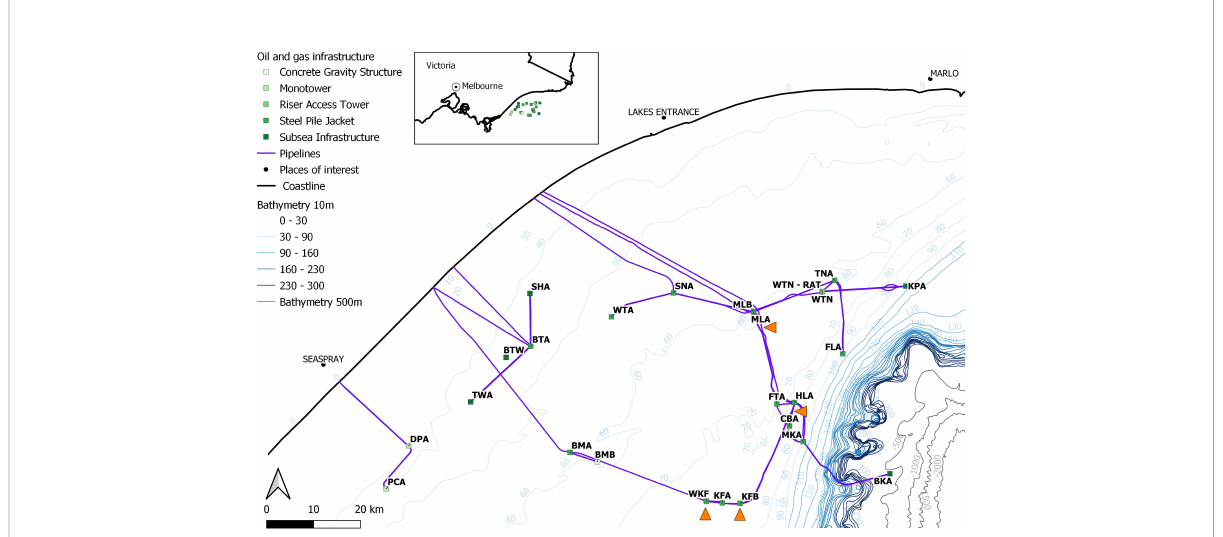
FIGURE 1 Map of Esso Australia Resources Pty Ltd (EARPL)-operated oil and gas structures in the Gippsland Basin of the Bass Strait region, south-east Australia. An inset map shows the location of the structures along the coastline east of Melbourne in the state of Victoria. Each platform is identi fi ed with the structure type. The platforms and pipelines included in this study are indicated by the orange triangles. Map created in